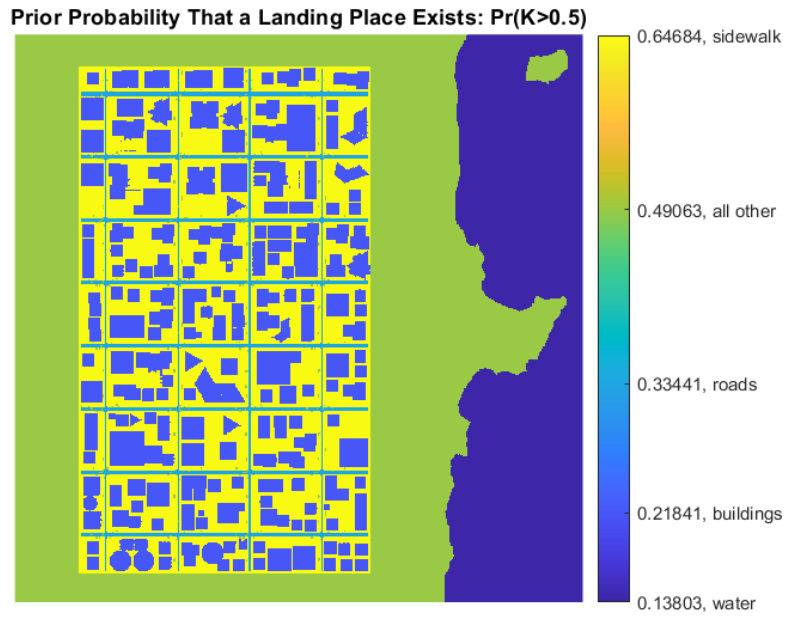
Figure 8. Prior α and β parameters for each cell in the urban scene.